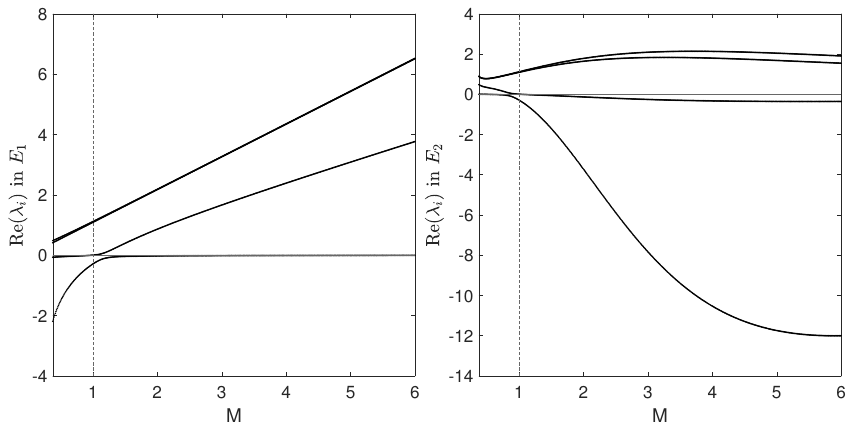
Figure 4. Eigenvalues of the Jacobian J | E of degrees of freedom: δ = 8, θ = 0.05, Pr = 0.761 which corresponds to ν = − 0.33.